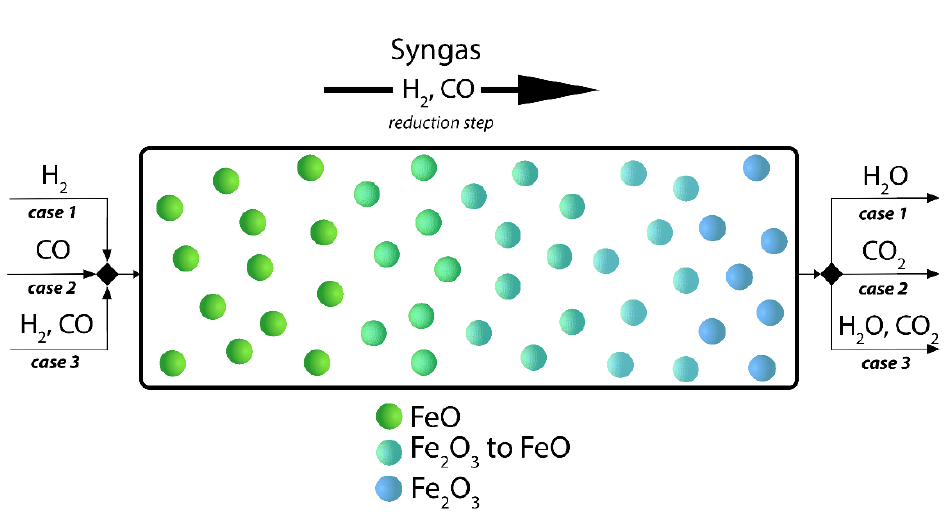
Figure 1. The reduction step of the CLC process using iron-based OC.